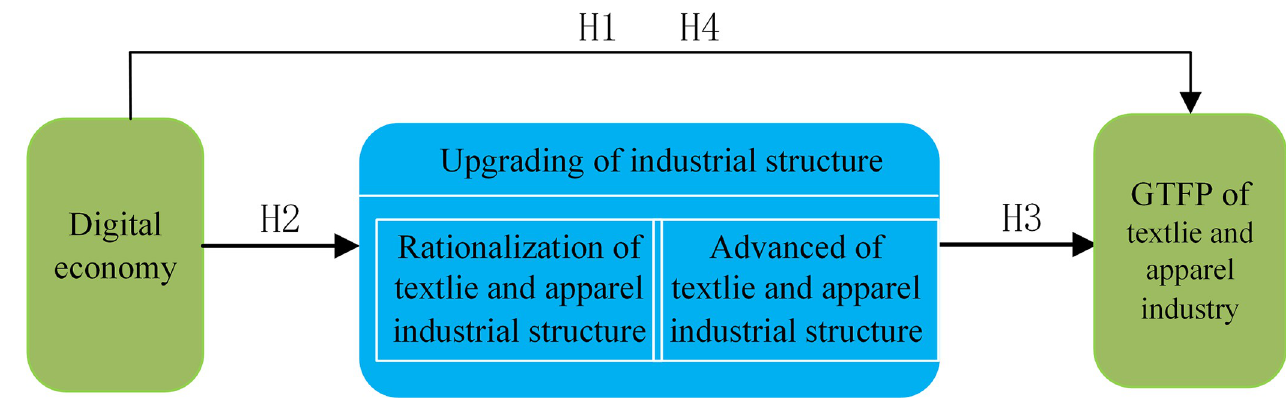
Fig 1. Theoretical framework for the impact of the digital economy on